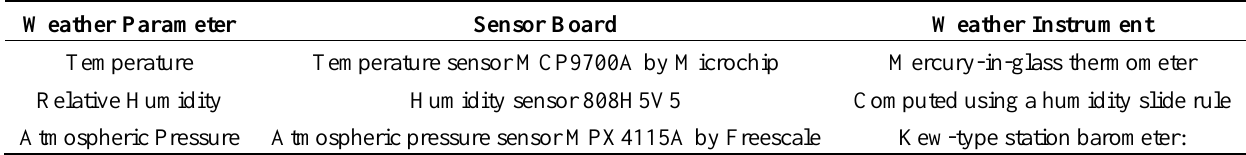
Table 1. Details of the sensor equipment used.